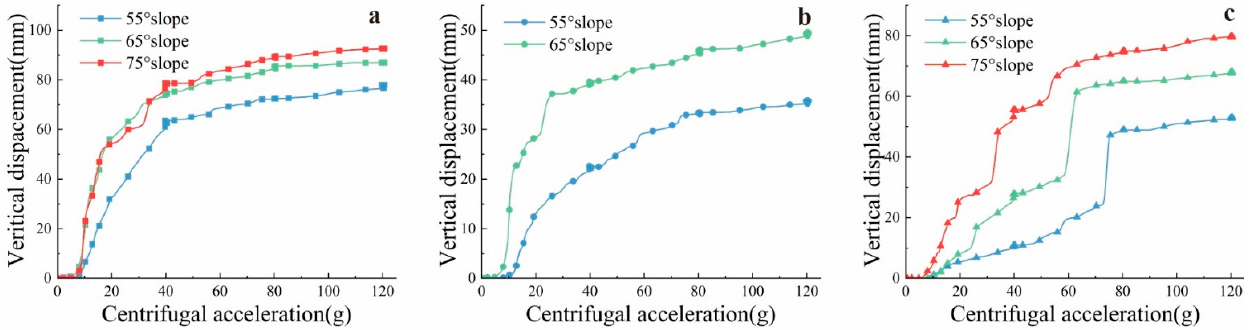
Figure 8. Variation curves for the vertical displacements of the monitoring points, ( a ) LVDT1, ( b ) LVDT2, ( c ) LVDT3. ( b ) LVDT2, ( c )